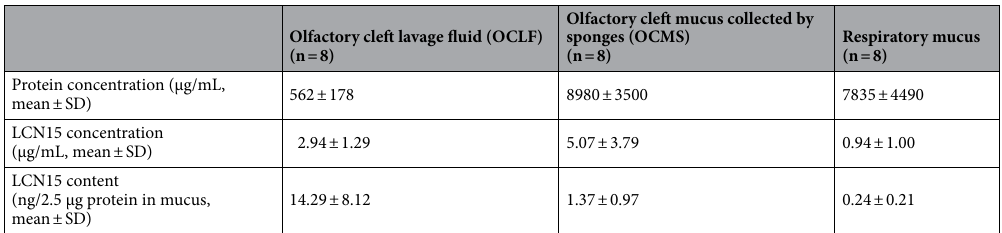
Table 3. Total protein and LCN15 concentration in the mucus samples.